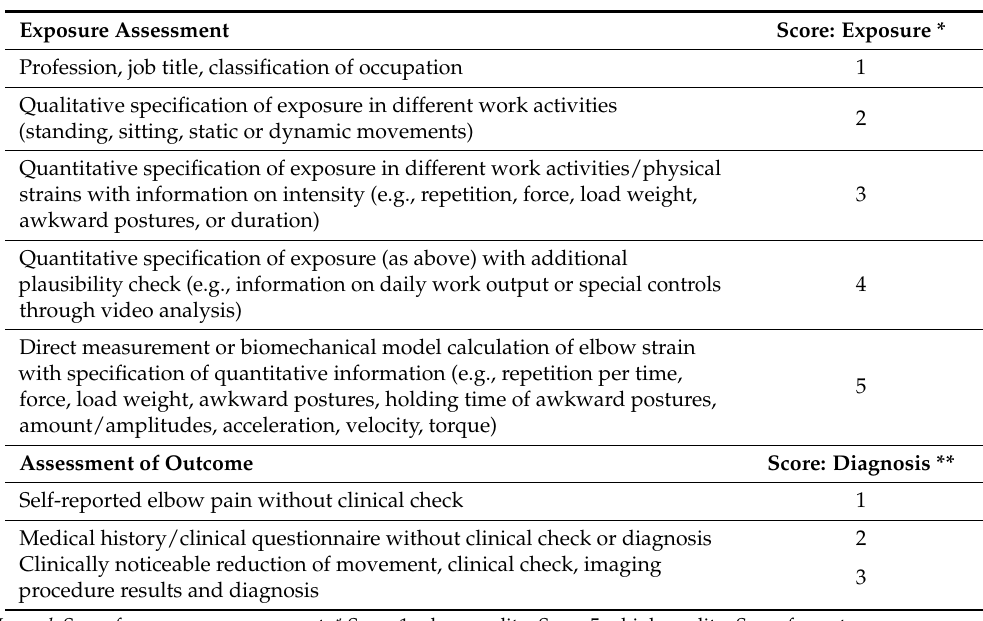
Table 2. Applied quality assessment of exposure and